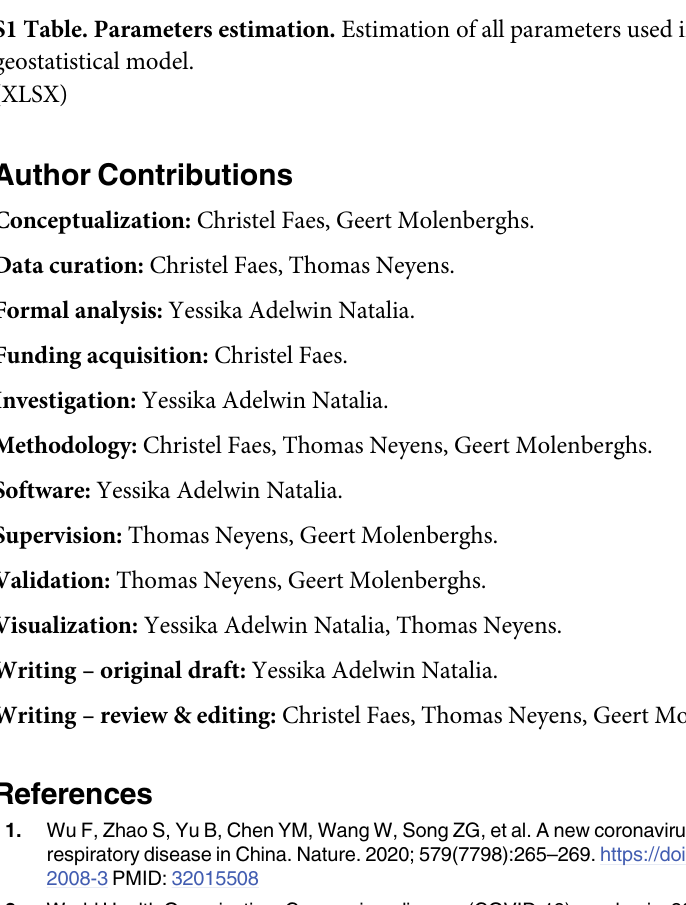
S2 Fig. Standardized incidence rate per 100,000 population at region level. S3 Fig. Predicted COVID-19 incidence per 1000 population at municipality level. Different legend scales were used to accommodate the difference between two regions before and after